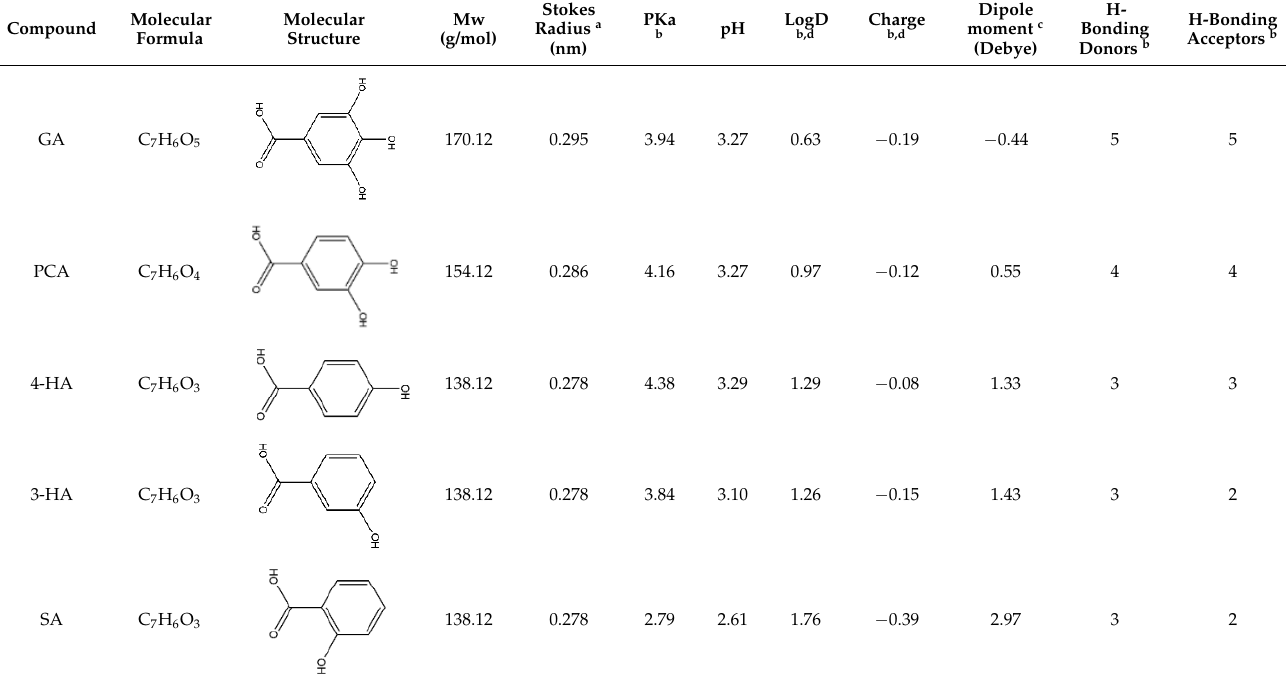
Table 1. Physicochemical properties for the selected phenolic acid compounds.